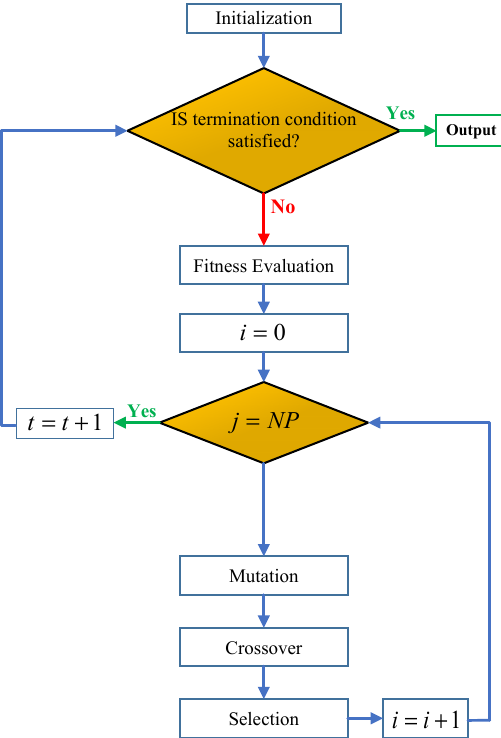
Figure 9. Differential evolution algorithm flowchart [50]. Figure 9. Di ff erential evolution algorithm flowchart